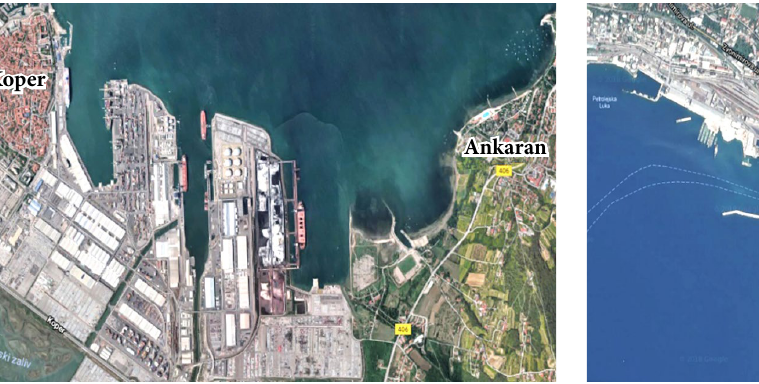
Figure 4. Port of Rijeka and the city of Rijeka ( https: // www.google.com / maps